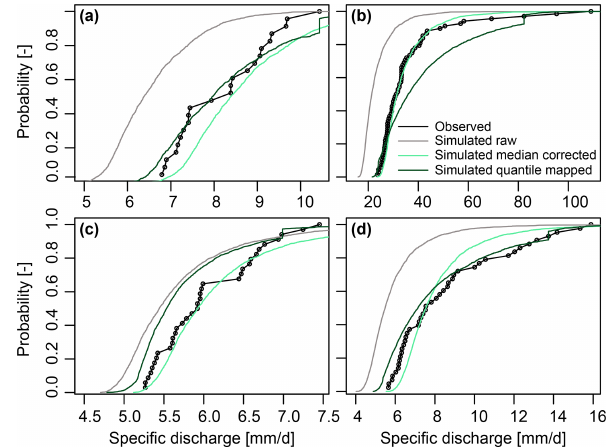
Figure 3. Comparison of observed and simulated cumulative dis- tribution functions of peak-over-threshold flood events derived from observed streamflow time series, raw simulations without any bias correction, flood events corrected by the median ratio between observed and simulated flood distributions, and empiri- cally quantile mapped simulations for the four example